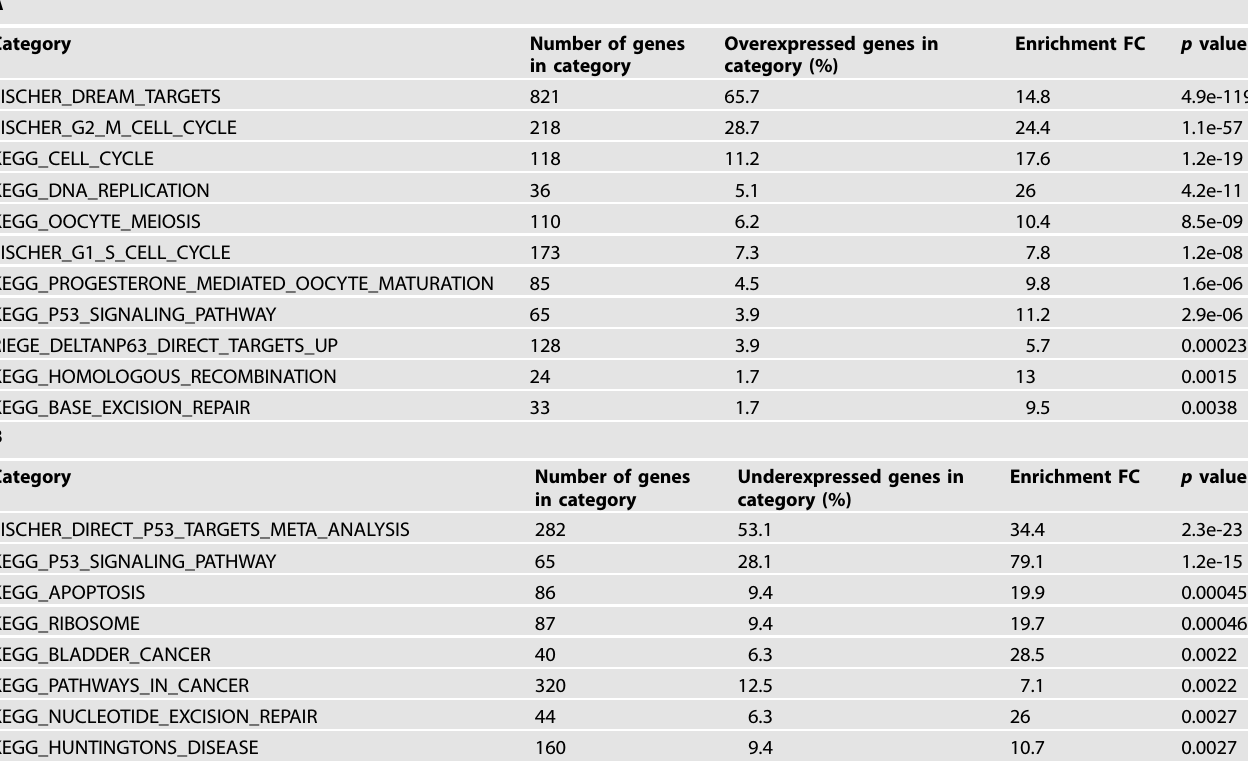
Table 1. Functional analysis of the pan-cancer consensus list of differentially expressed genes between TP53mut and TP53wt tumors.